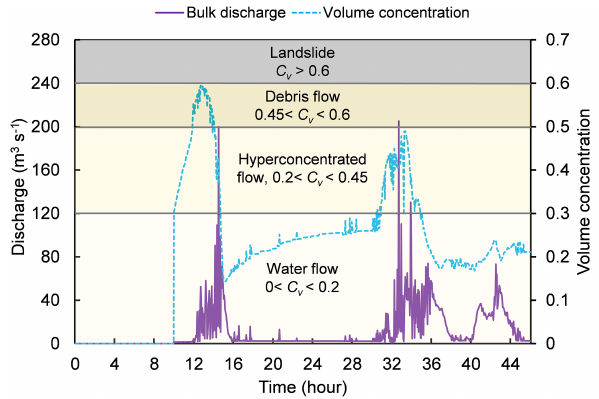
Figure 12. Outflow hydrograph and changes in C v at the Xiaojiagou Ravine mouth during the simulation